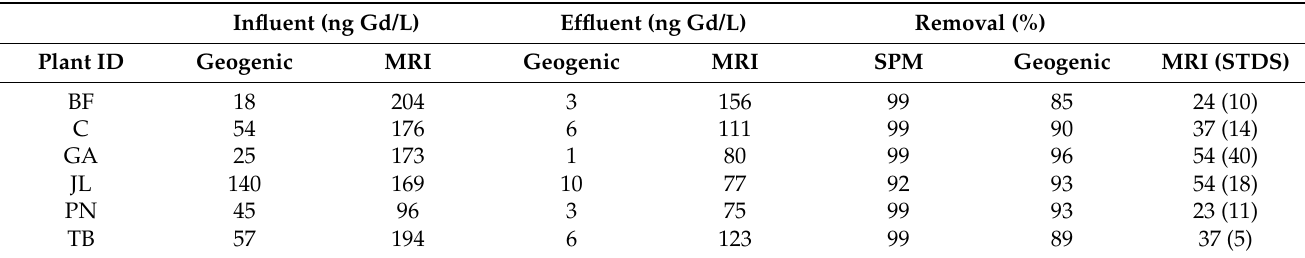
Table 4. Concentration of the geogenic Gd and Gd complex associated with medical resonance imaging (MRI) in influents and effluents. Efficiency rate for removing suspended particulate matter (SPM), geogenic Gd and that resulting from medical